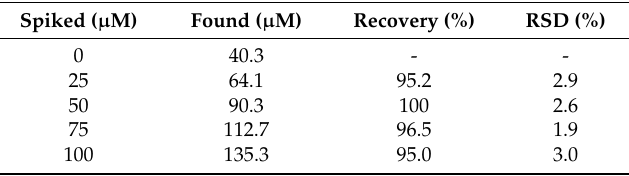
Table 2. Determination of glucose in a juice on